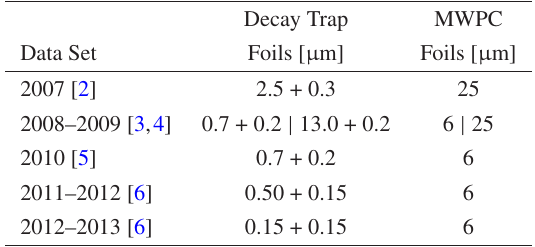
Table 1. Summary of the decay trap and MWPC foil thicknesses over the course of the running of the UCNA experiment. Prior to the 2012–2013 data taking run, the decay trap foils consisted of Mylar coated with Be (such that, e.g., “2.5 + 0.3” indicates 2 . 5 µ m of Mylar coated with 0 . 3 µ m of Be). For the 2012–2013 data taking run, the decay trap foils consisted of 0 . 15 µ m thick 6F6F foils [14] coated with 0 . 15 µ m of Be. For all years, the MWPC foils were composed of Mylar.